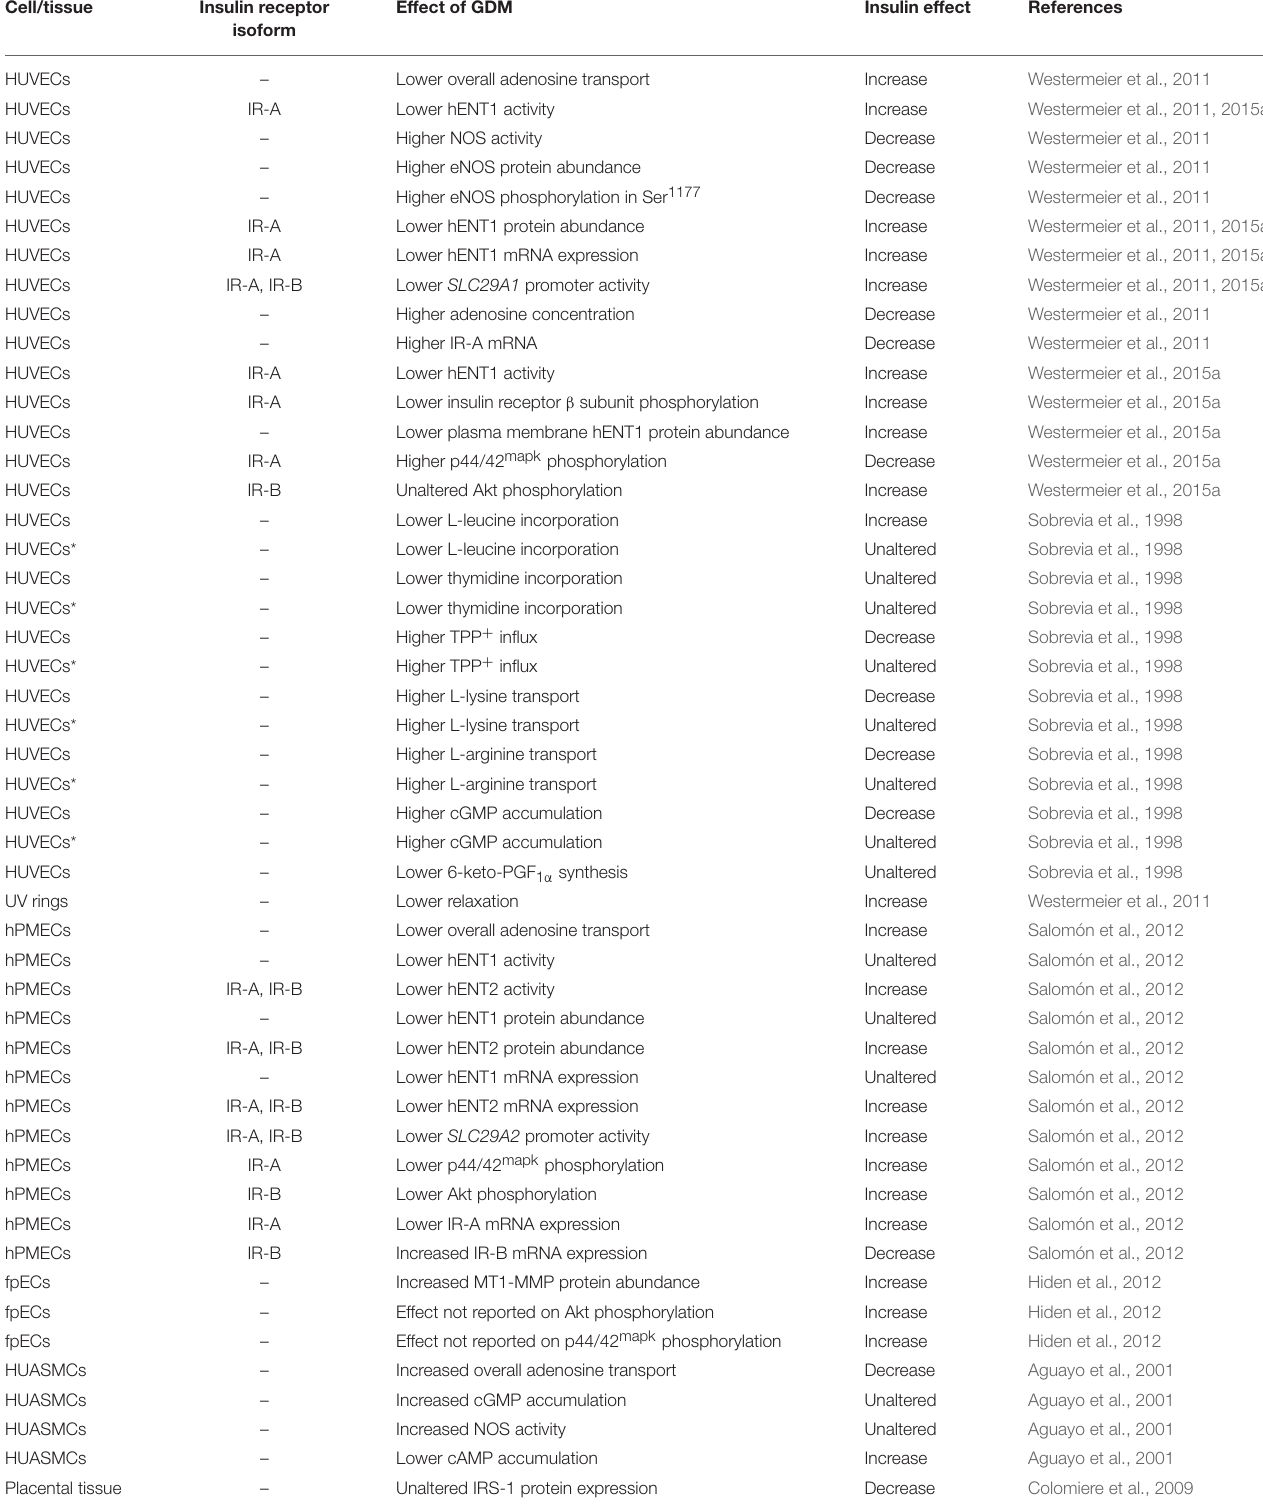
TABLE 1 | Effect of insulin on human fetoplacental vasculature in